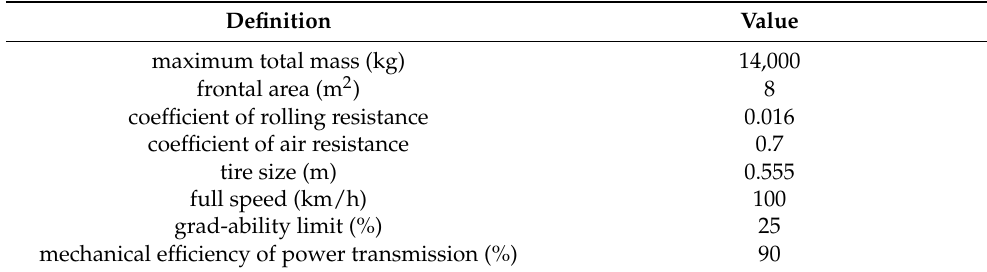
Table 2. Vehicle parameters.